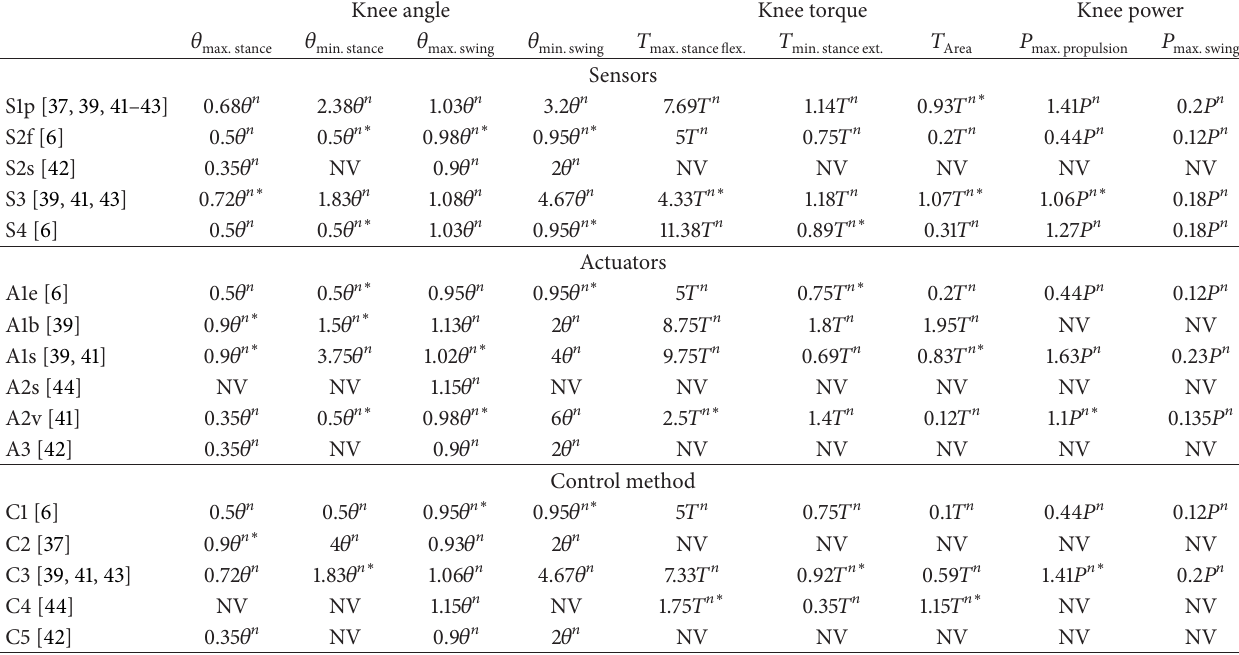
Table 2: Normalized knee gait parameters, 𝑄 , of individual components in active prosthetic systems. 𝜃 max.stance